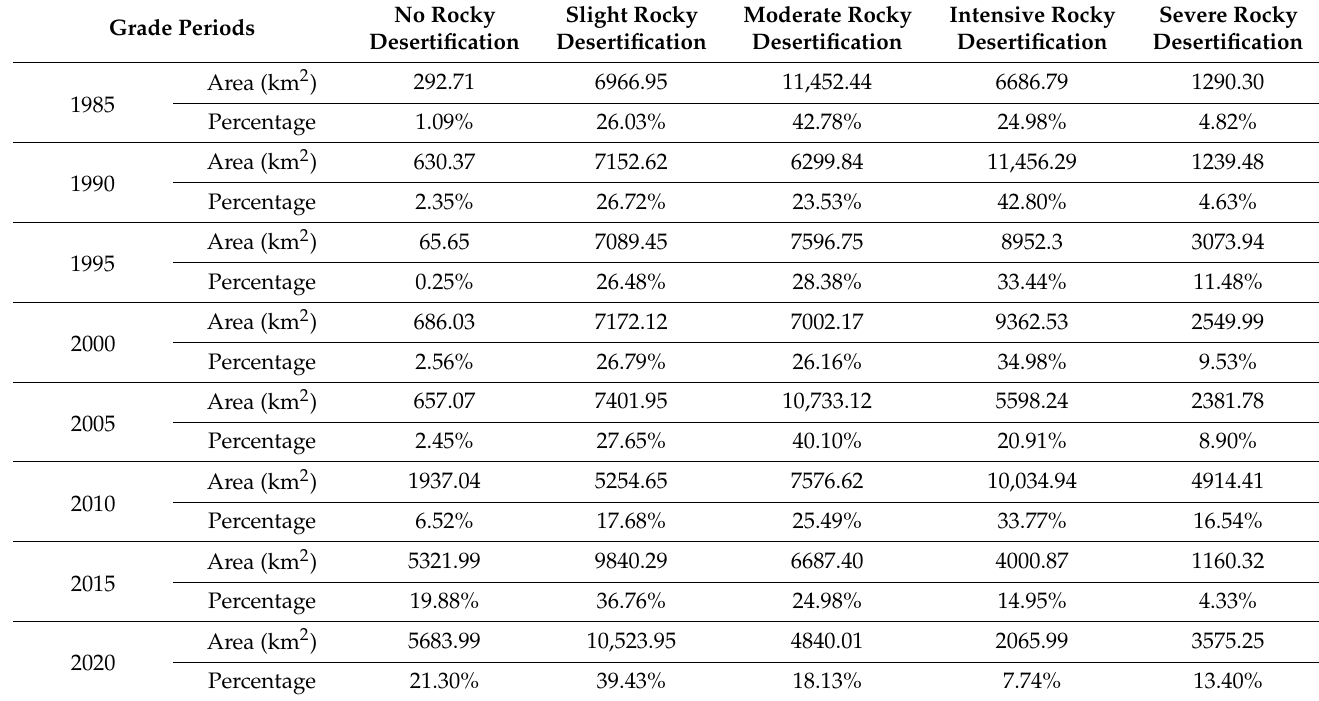
Table 3. The proportions of the levels of the rocky desertification area in different